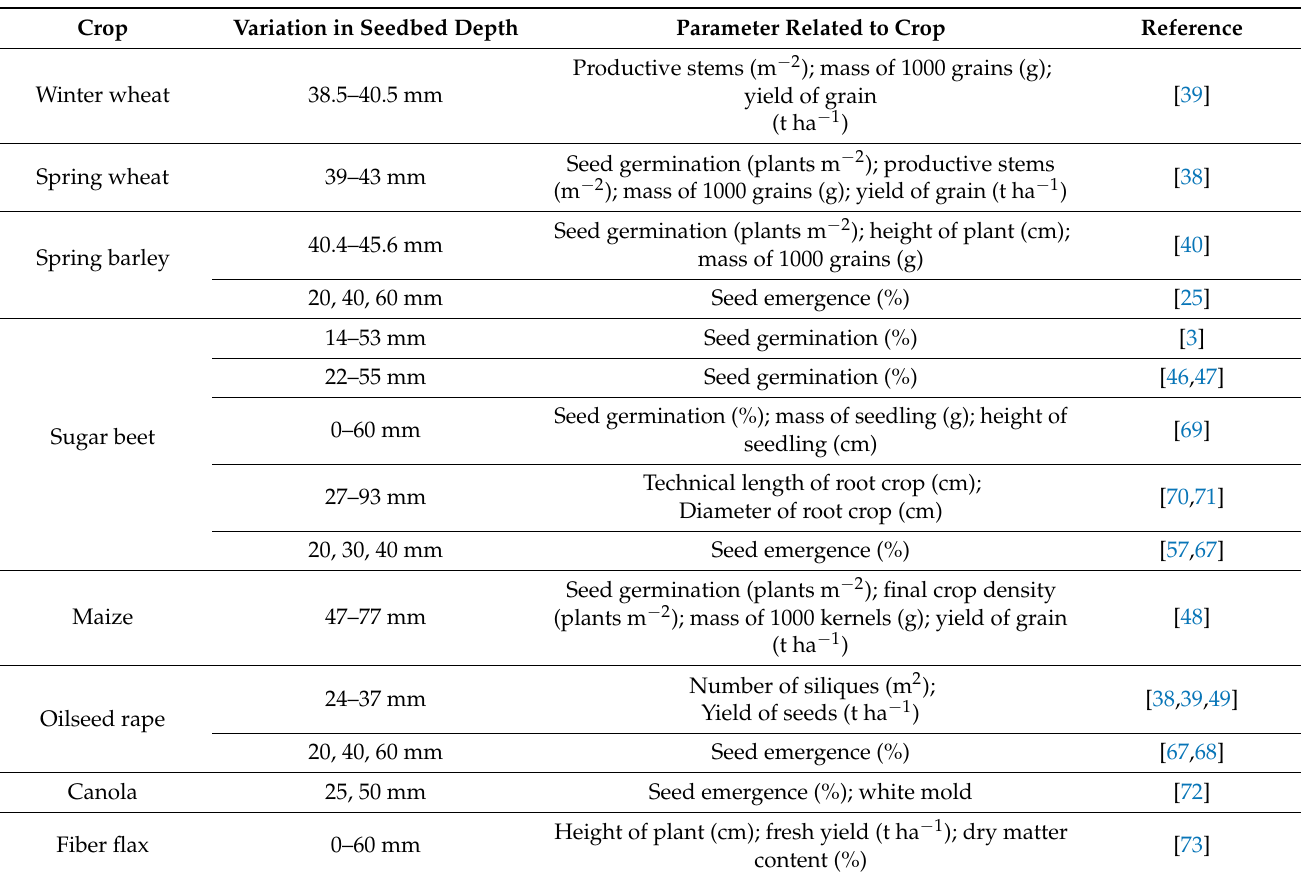
Table 2. Relation of seedbed depth to crop germination, development, quantity and quality parame-